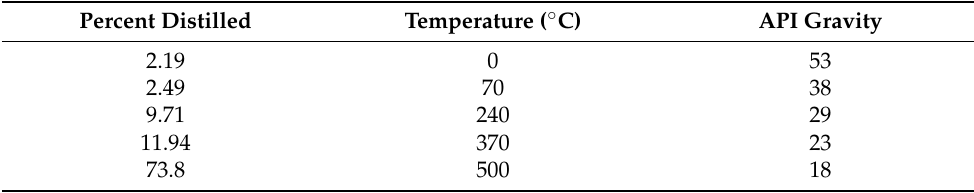
Table 3. TBP (liquid volume basis) and API gravity curve of Al-Fula crude oil. Percent